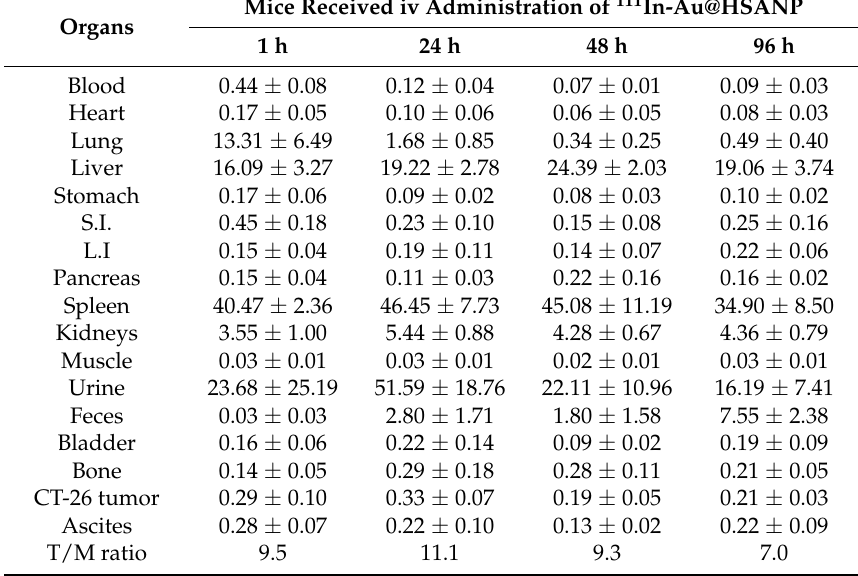
Table 3. Radioactivity distribution of 111 In-Au@HSANP in CT-26 tumor/ascites mice at one, 24, 48, and 96 h post intravenous administration.